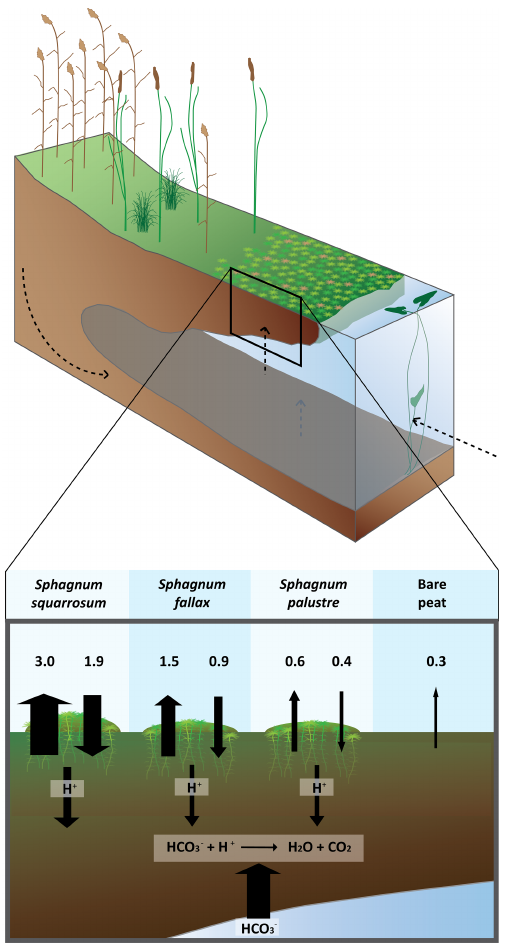
Figure 4. Schematic overview of a transitional floating mire in- fluenced by HCO − -rich groundwater or surface water, illustrated 3 by dashed arrows in the figure above. Due to differences in the thickness of the floating peat and the origin and composition of the HCO − -rich water, there is high heterogeneity within these systems. 3 Part of the floating raft is shown in more detail below. Here, peat soils are covered with different Sphagnum species. Rates of C fix- ation in peat (downward arrow) and C emission to the atmosphere (upward arrows) are both derived from C flux measurements and presented in gCm − 2 d − 1 . As the mosses showed differences in fi- nal biomass, higher or lower amounts of biomass are depicted in the figure. Furthermore, the mosses differ in acidification rate, with significantly higher amounts of acids produced by Sphagnum squar- rosum (left) than the other species. Since Sphagnum magellanicum declined severely in biomass due to its sensitivity to the calcare- ous water, its C fluxes could not be measured and the species was excluded from this